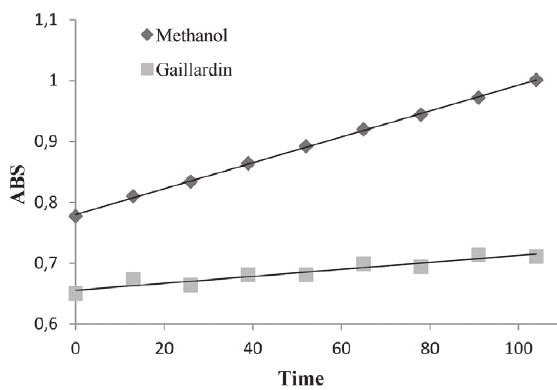
Figure 2 - AChEI activity in presence of methanol and gaillardin as described in methods.